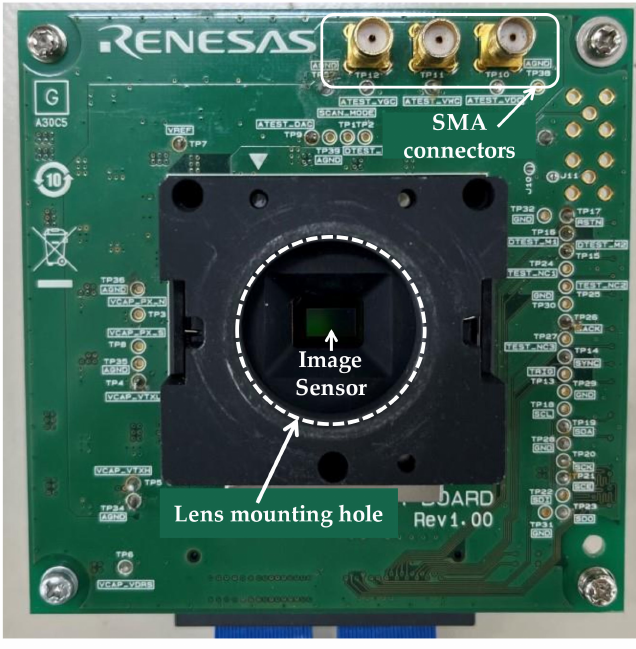
Figure 11. Sensor